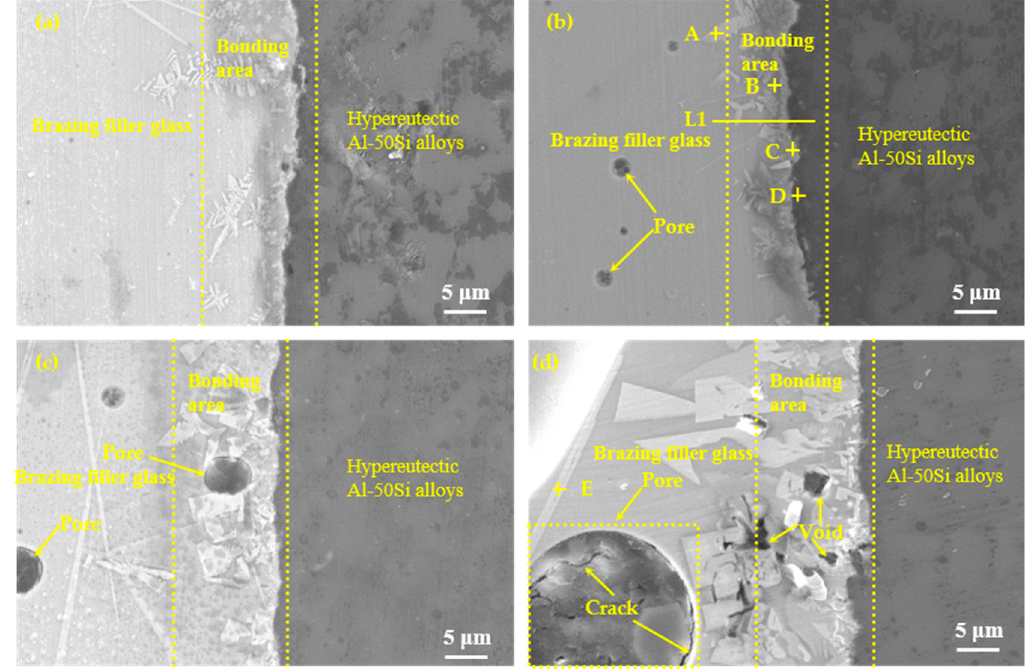
Figure 9. Microstructure evolution of the joints as function of temperature with holding time 30 min: ( a ) 475 °C; ( b ) 495 °C; ( c ) 515 °C and ( d ) 535 °C.